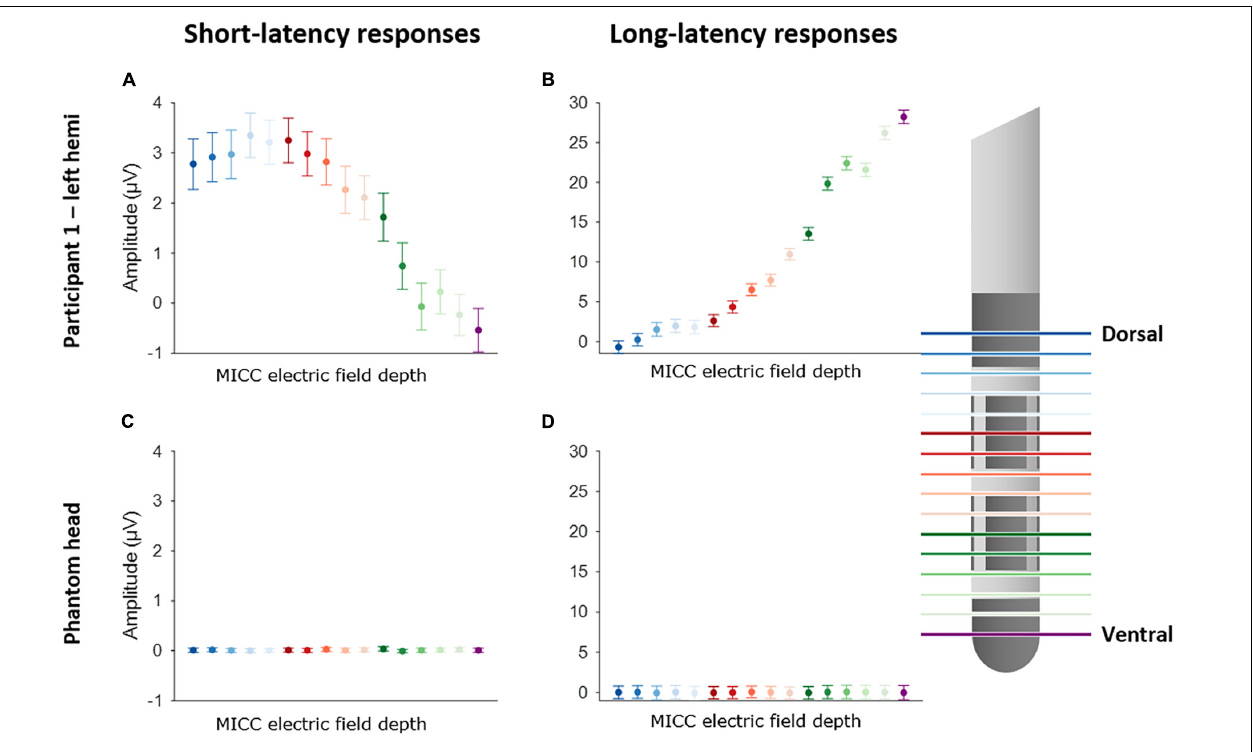
FIGURE 2 | Effect of using MICC to change the center of the electric field on P3 and P10 amplitude. Left panels show the effect of MICC technology on P3 amplitude for participant 1 (A) and the phantom head (C) . Right panels show the effect on P10 amplitude for participant 1 (B) and the phantom head (D) . Each EP is colored differently, as is indicated on the legend on the right side. The dots show the mean peak amplitude (P3 or P10) calculated across all epochs ( n = 400), the error bars show the 95% confidence interval (CI).